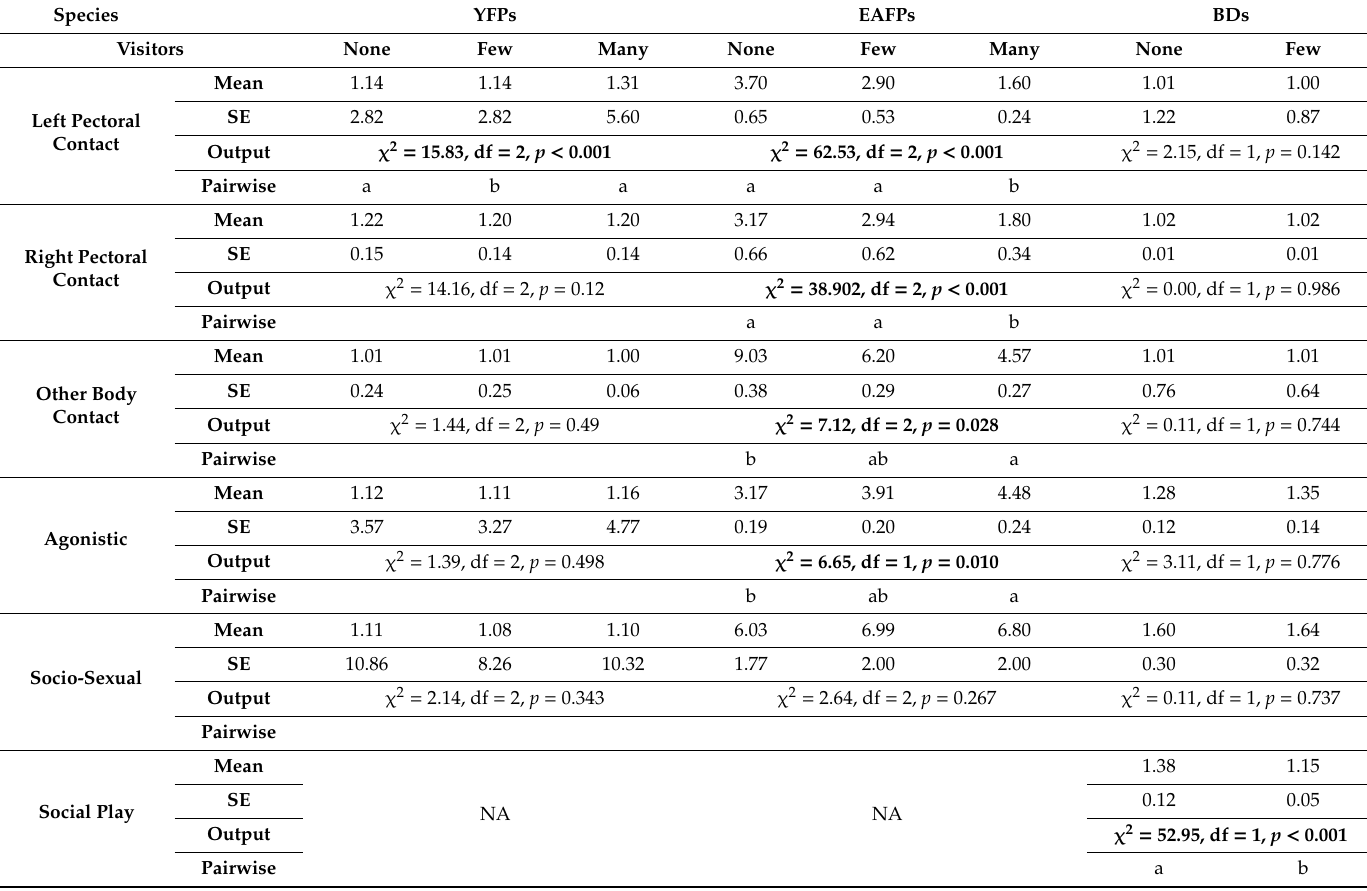
Table 9. Fitted means and standard errors of the frequency of each social behaviour, depending on visitors for Yangtze finless porpoises (YFPs), East-Asian finless porpoises (EAFPs) and bottlenose dolphins (BDs). Outputs come from Wald chi-squared tests run on Generalized linear mixed models, significant outputs are bolded. For each species and each behaviour, items sharing the same letter did not di ff er significantly, items that do not share the same letter di ff er significantly (post-hoc tests with sequential Bonferroni